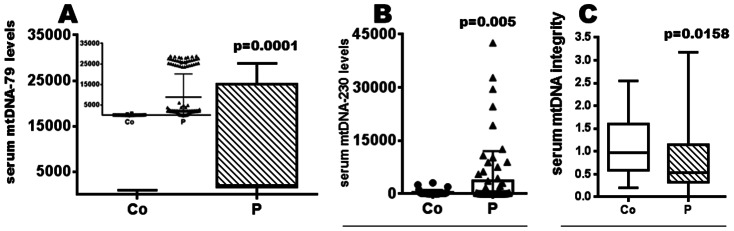
Exposure to halo alkanes enhances relative serum levels of mtDNA.Relative serum levels of mtDNA-79 (A), mtDNA-230 (B) or the mtDNA integrity in controls (Co) and exposed (P) groups. A. The distribution of circulating mtDNA-79 is presented as a box plot indicating all data from minimum to maximum and median values (as cross line). The inset additionally shows a jittered scatter plot and its mean ±SD values. The additionally performed meta-analysis (Fisher’s method) revealed a p-value of 0.0042. B. The distribution of circulating mtDNA-230 shown as a scattered plot (min./max.) with incorporated box plot. C. A whisker box plot comparing the mtDNA integrity between the exposed patients (P) and healthy unexposed individual is shown.